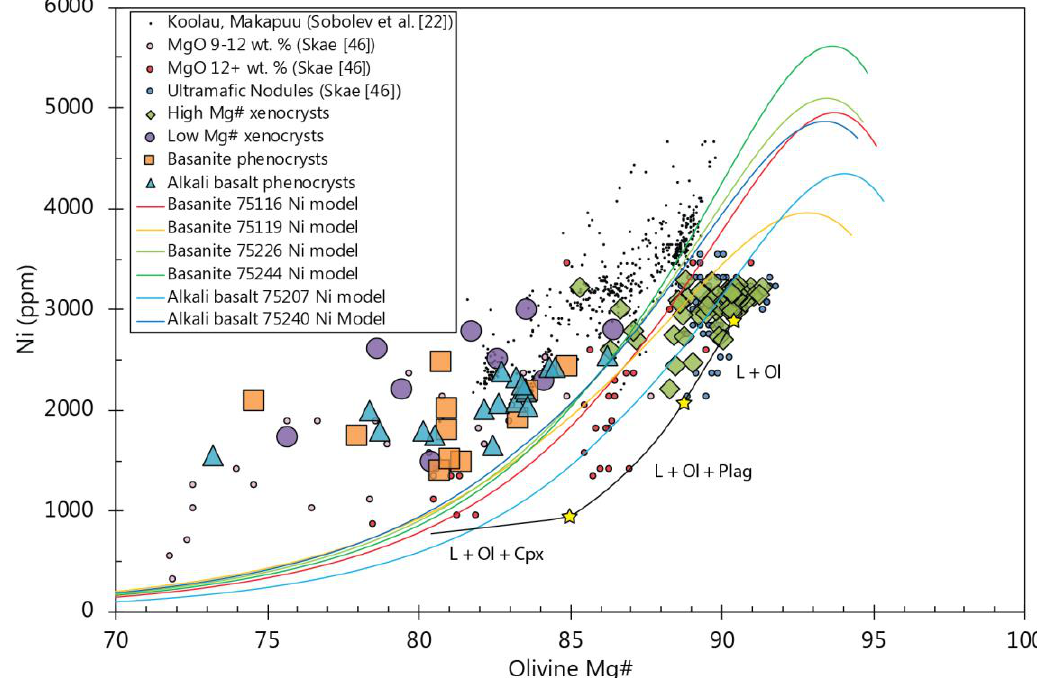
Figure 7. Buckland olivine Ni plotted against Mg#, where lines are the modelled Ni and Mg# based on the composition of the groundmass, assuming a peridotite source assemblage [73]. The olivine liquid line of descent is from Figure 6 of Herzberg et al. [5], and is based on an upper mantle peridotite source with 0.2% H 2 O. Ni concentrations of the Buckland alkali basalts, basanites and low Mg# xenocrysts all plotted above the modelled olivine compositions for a peridotite-derived source.